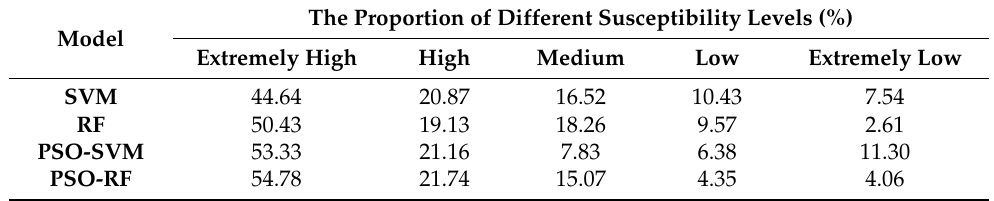
Table 5. Percentages of landslide points falling into different susceptibility levels.